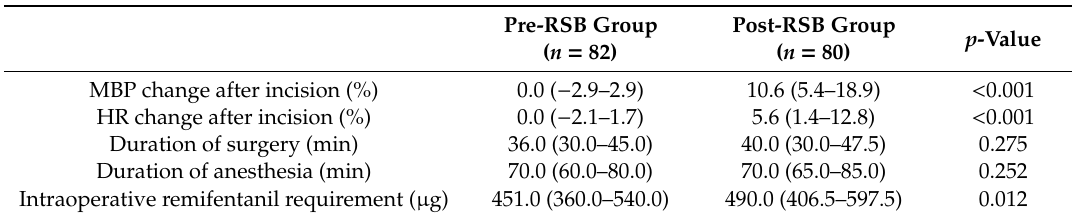
Table 2. Intraoperative